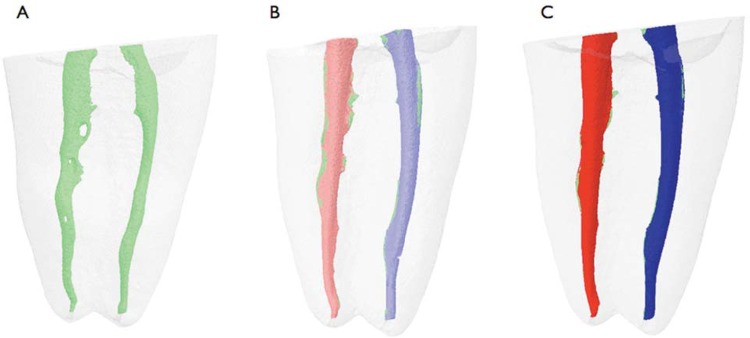
Three-dimensional reconstructions of mesial root canals of a mandibular molar: (A) before instrumentation (green), (B) after instrumentation with the ProTaper Gold F2 (light red), and the ProTaper Universal F2 file (light blue). (C) Shows the mesial canals after instrumentation with ProTaper Gold F3 (dark red) and the ProTaper Universal F3 file (dark blue)